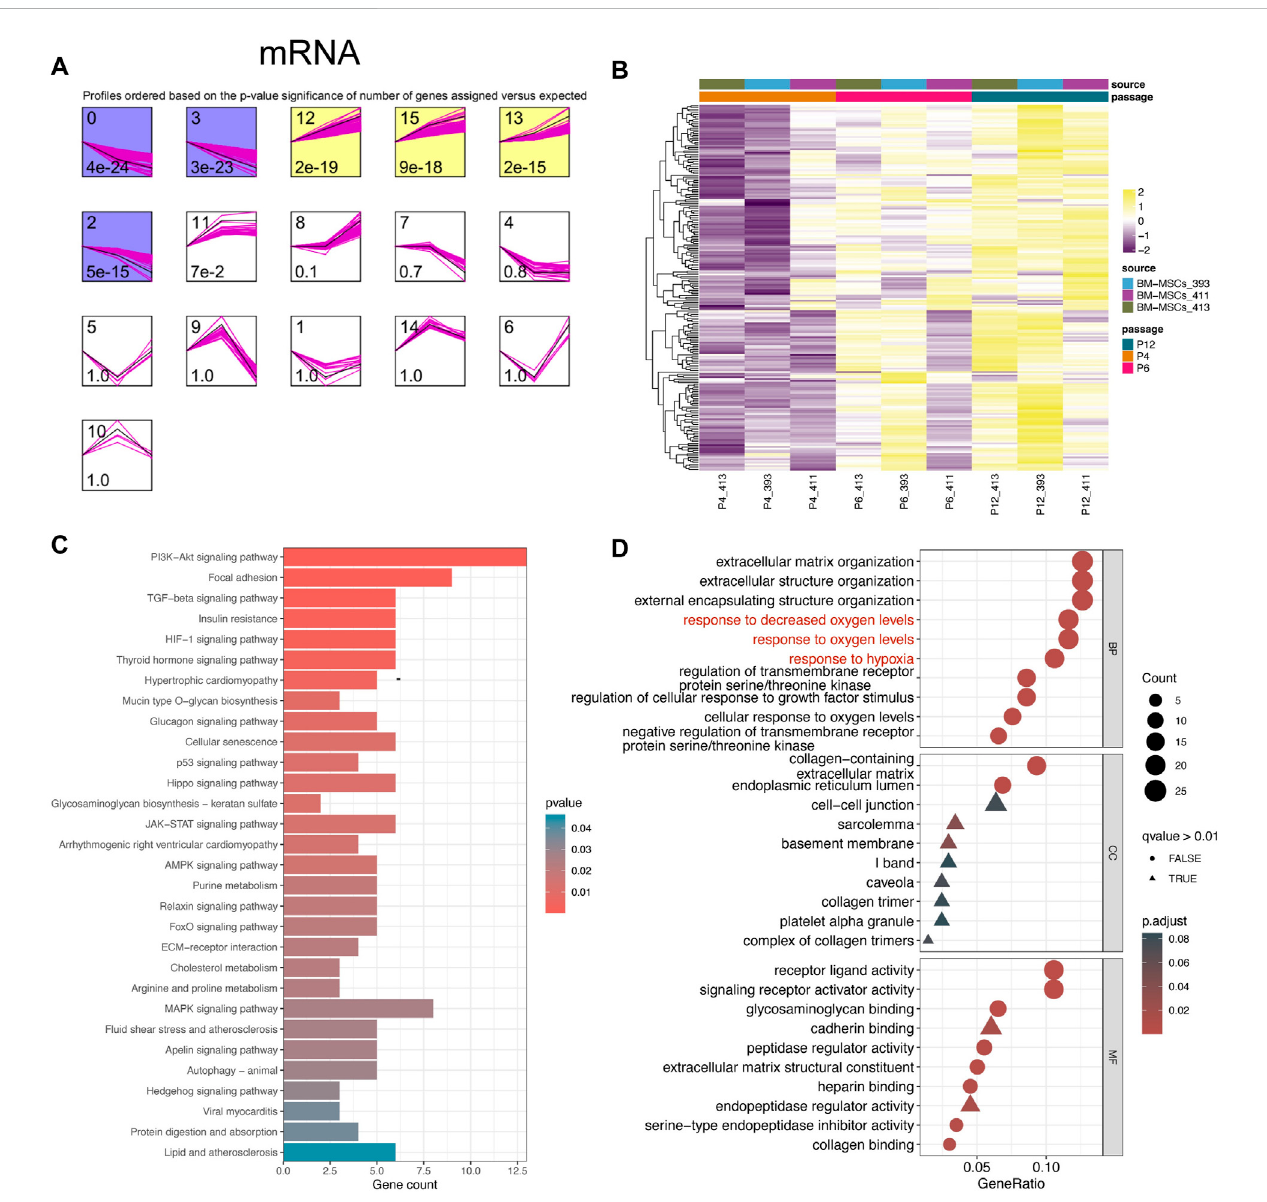
FIGURE 2 Upwardly expressed mRNAs in MSCs cultured in vitro . (A) STEM analysis of bulk RNA-seq data. (B) Heatmap plots 210 mRNAs that were gradually upregulated from P4 to p12. (C) KEGG analysis of210 genes. The top 30important termsare displayed. (D) GO analysis of210 genes. The top 10 crucial terms for biological process (BP), cellular component (CC), and molecular function (MF) are